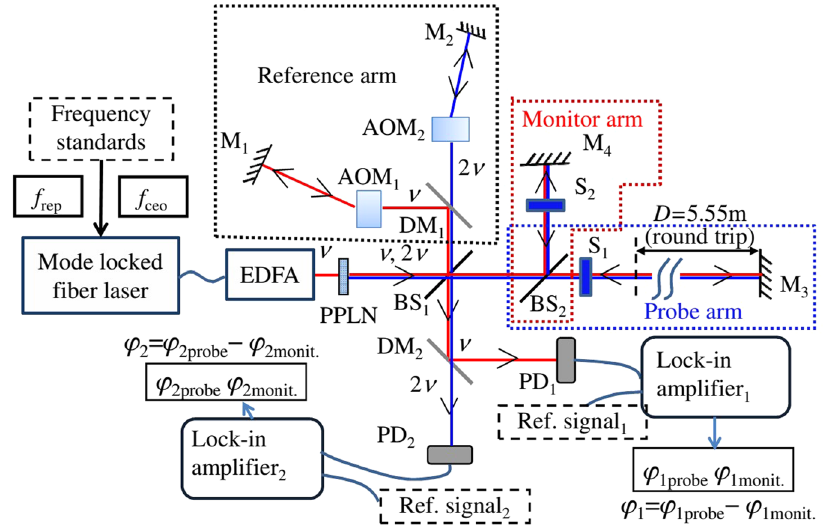
Figure 8. Two-color heterodyne interferometers of optical frequency combs 20 .